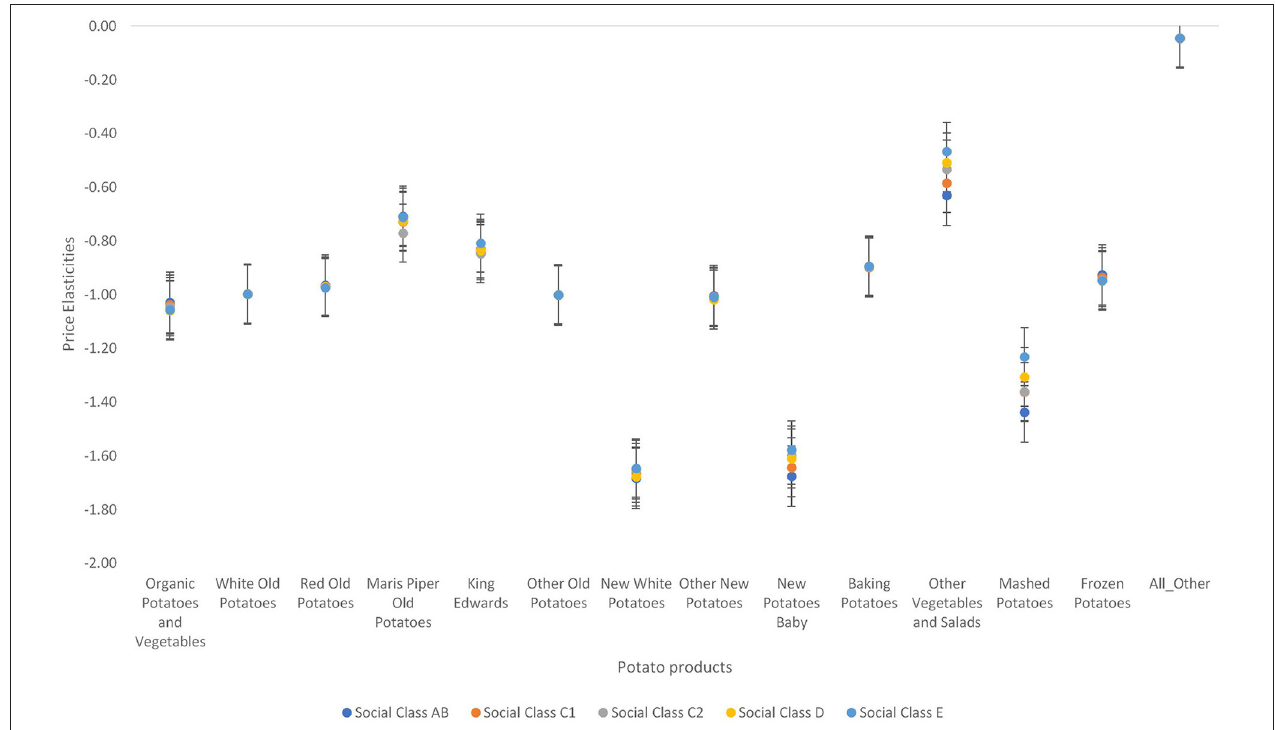
FIGURE 6 | Variations in own price elasticities across different social class in the United Kingdom.